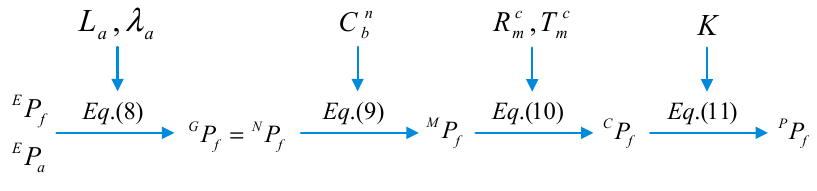
Figure 5. Projection of features in synthetic image .